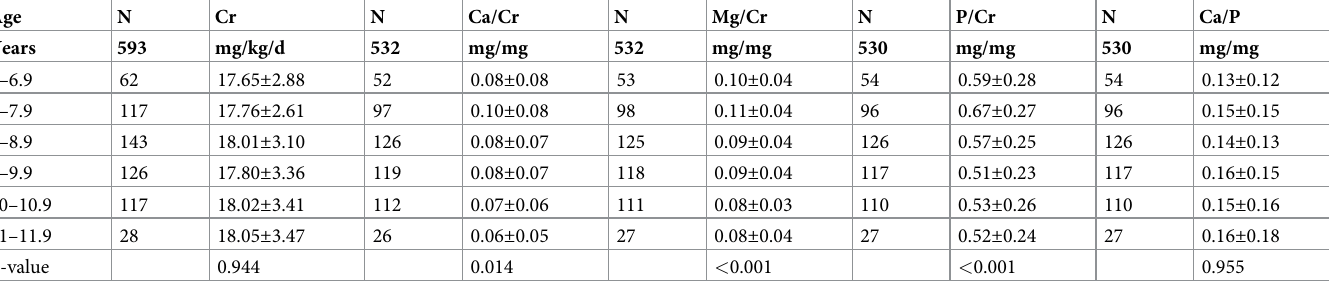
Table 4. Urinary Ca/Cr, Mg/Cr, P/Cr, and Ca/P ratios among elementary Emirati schoolchildren of varied age